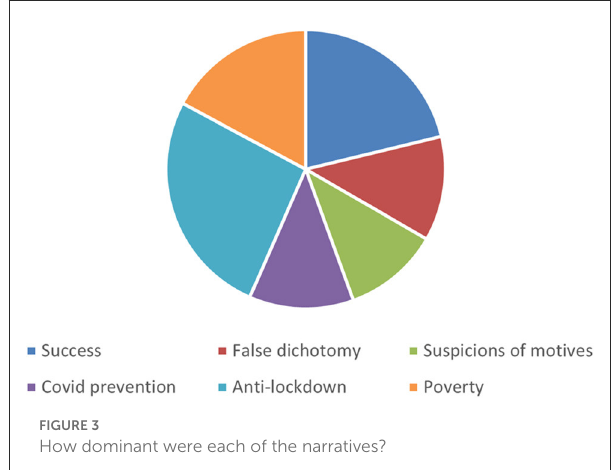
FIGURE3 How dominant were each of the narratives?